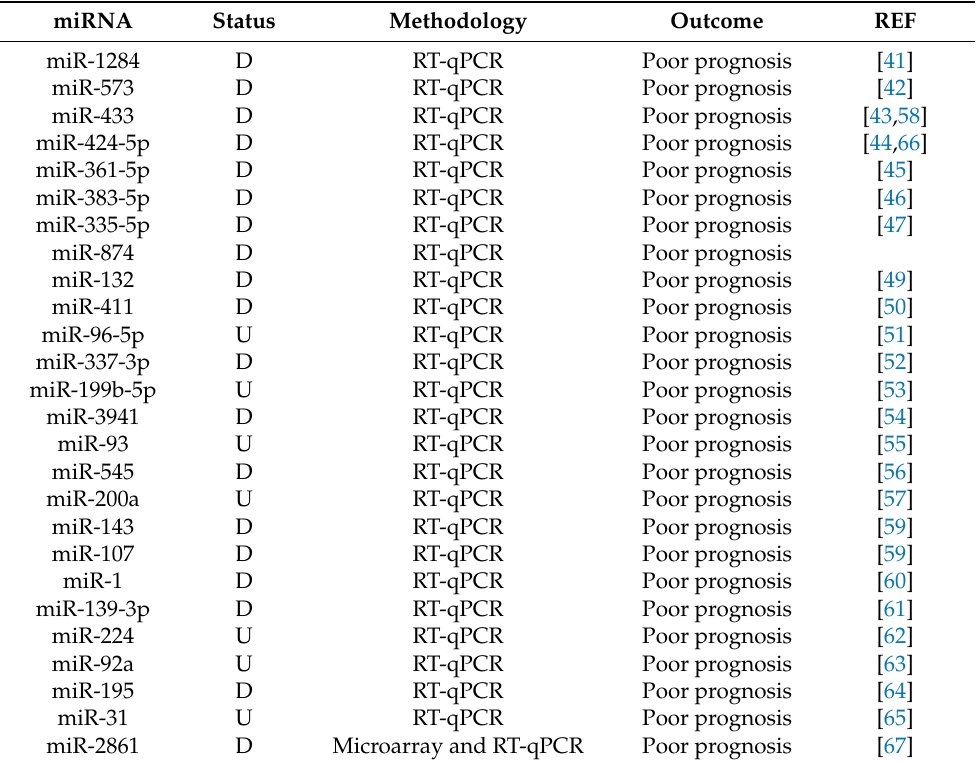
Table 4. miRNAs involved in cervical cancer’s clinical